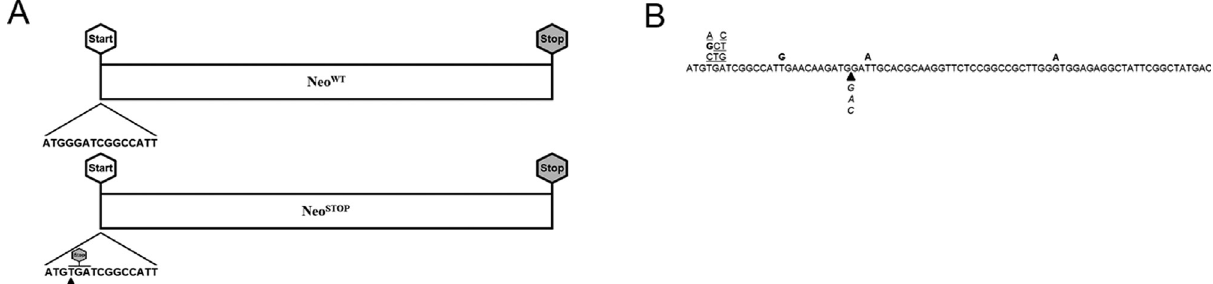
Figure 2 - Construction of the Neo stop reporter and manually predicted mutations within its first seventy nucleotides. (A) The Neo stop reporter was con- structed substituting a guanine for a thymine at position 4 (as indicated by the arrow), generating the stop codon TGA right after the start codon ATG, as described in Materials and Methods , item 1. (B) Manually predicted spontaneous and oxidation-induced mutations within the first seventy nucleotides of the Neo stop reporter are indicated by underlined and bold-type letters, respectively. Insertion of a guanine, cytosine, and adenine at position 26 (indicated by italicized letters) can convert the ATG sequence found at positions 23-25 into an in-frame start